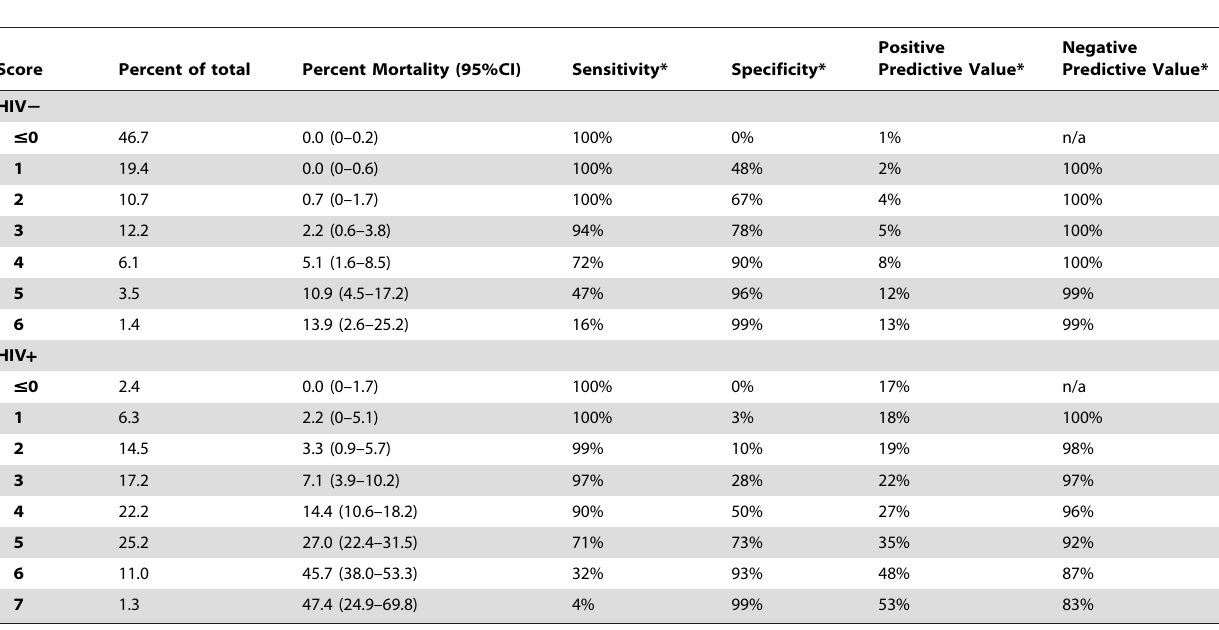
Table 4. Distribution of RISC scores and screening performance in children , 24 months of age with and without HIV infection, hospitalized with LRTI in Soweto, South Africa 1998–2001.